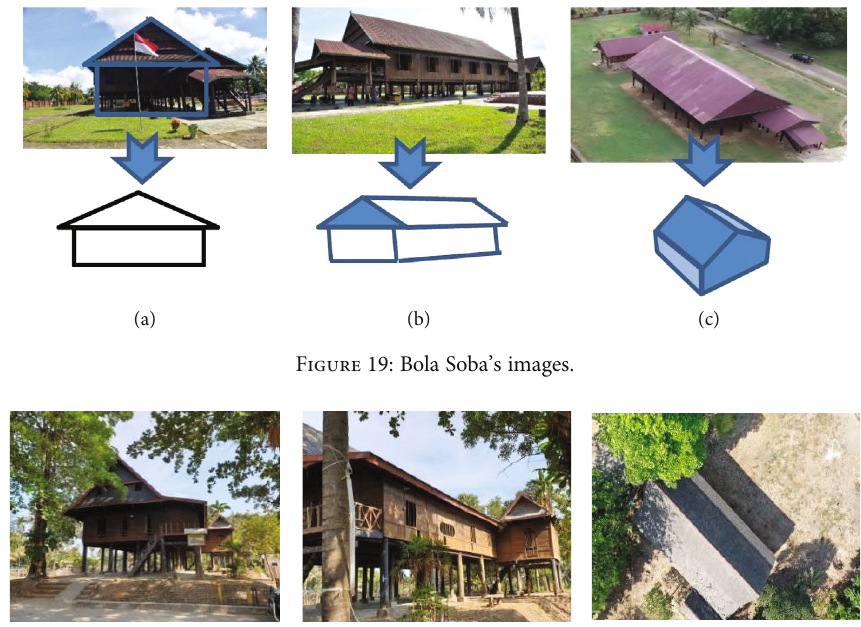
Figure 20: Buginese traditional